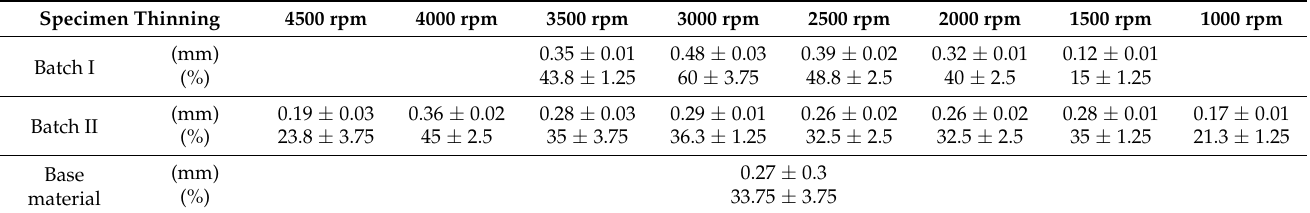
Table 5. The specimen thinning (measured from the macrographs as shown in Figure 14 in the middle of the stir zone for each specimen from the batch I and II and then subtracted from an initial value of specimen thickness 0.8 mm). Specimen Thinning 4500